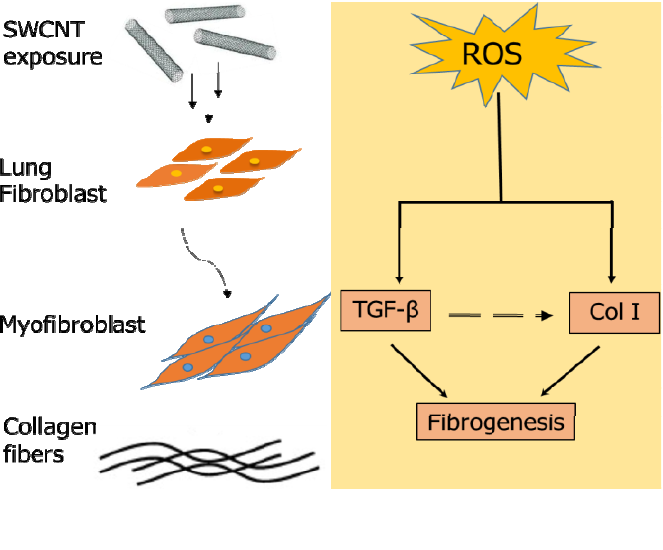
Figure 6. Schematic representation of mechanism involved during SWCNT-induced fibrogenesis. Reactive oxygen species (ROS) play a key role in SWCNT-induced collagen (Col I) and transforming growth factor-beta (TGF- β ) expression (solid arrows). ROS mediate collagen I and TGF- β upregulation, thereby inducing fibrogenesis (solid arrows). Furthermore, upregulation of TGF- β in turn increases collagen production via fibroblast and myofibroblast proliferation (dashed